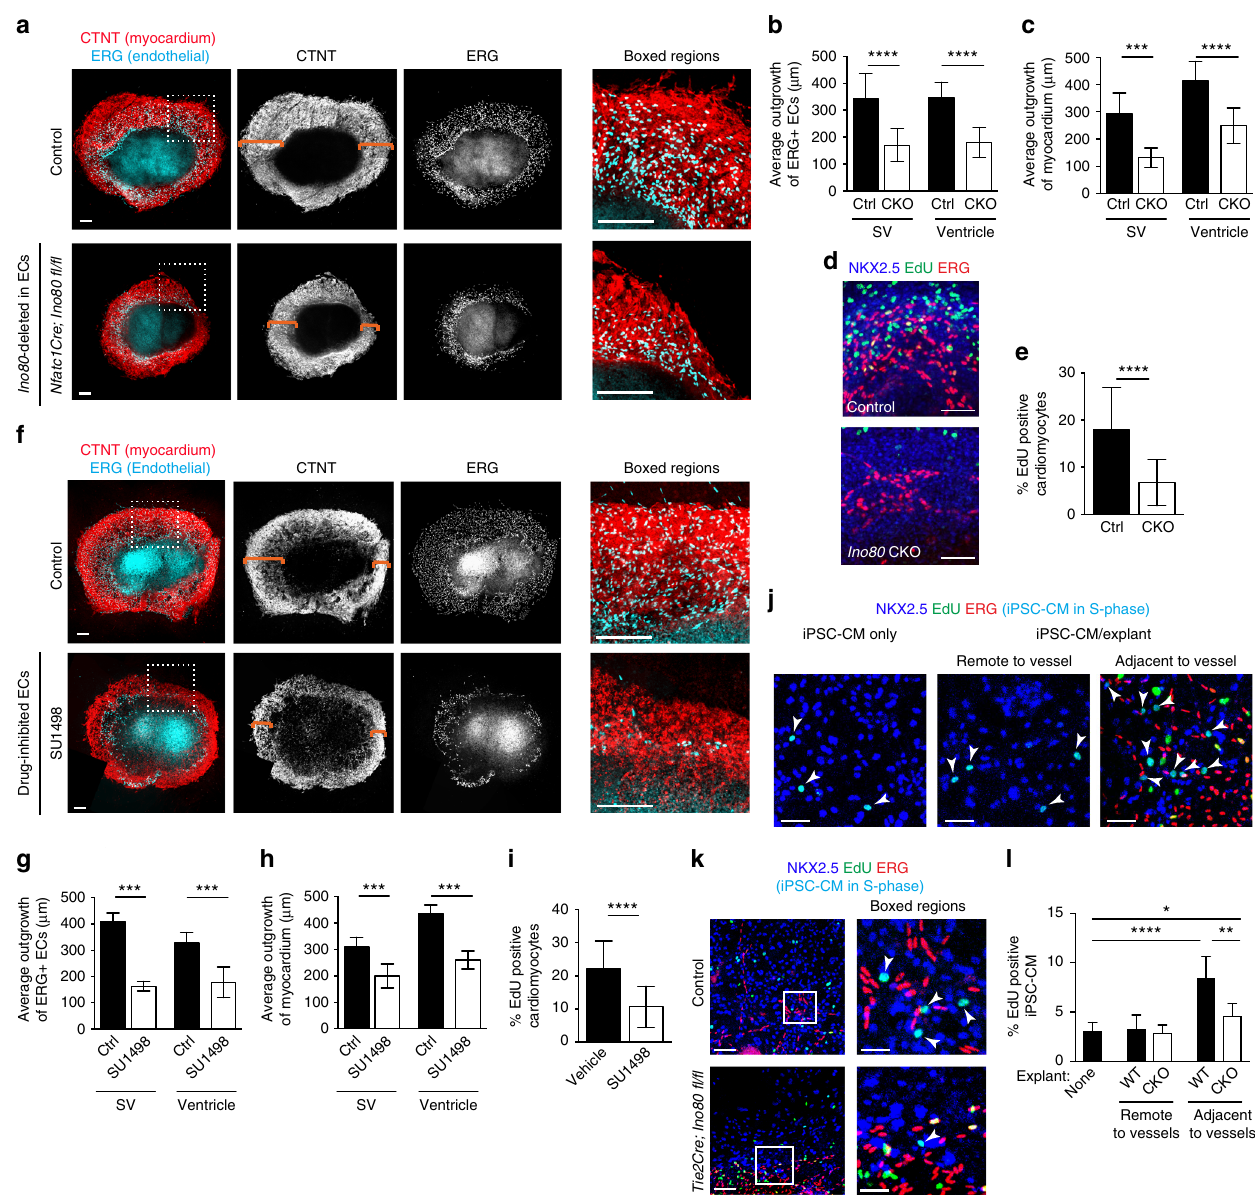
Fig. 6 Endothelial cells support myocardial growth in the absence of blood fl ow in an Ino80 -dependent manner. Heart ventricle and sinus venosus (SV) explants cultured for 5 days and immunostained for myocardium and endothelial cells. a Confocal images of ventricular explants show that expansion of myocardium (orange brackets) and endocardial-derived cells is decreased when Ino80 is deleted using Nfatc1Cre . Images are representative of the following number of replicates: control, n = 8 heart explants; mutant, n = 5 heart explants. Scale bars: 100 μ m (low and high magni fi cation). b – e Quanti fi cations show that endothelial sprouting ( b ), myocardial outgrowth (control, n = 8 heart explants; mutant, n = 5 heart explants) ( c ) and cardiomyocyte proliferation (control, n = 6 heart explants; mutant, n = 8 heart explants) ( d , e ) are signi fi cantly reduced. Images are representative of the following number of replicates: control, n = 6 heart explants; mutant, n = 8 heart explants. Scale bars: 100 μ m ( d ). Error bars in graphs are standard deviation. *** P < 0.001; **** P < 0.0001, evaluated by Student ’ s t -test ( d ). f – i Inhibiting endothelial cell growth through targeting VEGFR with SU1498 recapitulates the effect of Ino80 mutation ( f ), signi fi cantly decreasing vessels sprouting ( g ), myocardial expansion (control, n = 6 heart explants; SU 1498 treatment, n = 6 heart explants) ( h ), and cardiomyocyte proliferation (control, n = 10 heart explants; SU 1498 treatment, n = 8 heart explants) ( i ). Error bars in graphs are standard deviation. *** P < 0.001; **** P < 0.0001, evaluated by Student ’ s t -test. Scale bars: 100 μ m (low and high magni fi cation). Images are representative of the following number of replicates: control, n = 6 heart explants; SU 1498 treatment, n = 6 heart explants ( f ). j , k Images of human induced pluripotent cell-derived cardiomyocytes (iPSC-CMs) cultured either alone or with mouse ventricle explants. Proliferating NKX2.5 + EdU + iPSC-CMs are turquoise and indicated by arrowheads. Images are representative of the following number of replicates: control n = 10 heart explants, mutant n = 4 heart explants, iPSC- CM only control n = 7. Scale bar: 25 μ m ( j ); 100 μ m ( k ; low magni fi cation) and 25 μ m ( k ; high magni fi cation). l Quanti fi cation of iPSC-CM proliferation within three cells lengths from endothelial cells reveals a signi fi cant increase over regions distant from vessels or iPSC-CM cultures only (control n = 10 heart explants; mutant n = 4 heart explants; iPSC-CM only control n = 7). This increase is signi fi cantly dampened when endothelial cells are depleted of Ino80 . Error bars in graphs are standard deviation. * P < 0.05; ** P < 0.01; **** P < 0.0001, evaluated by Student ’ s t -test. Scale bars: 100 μ